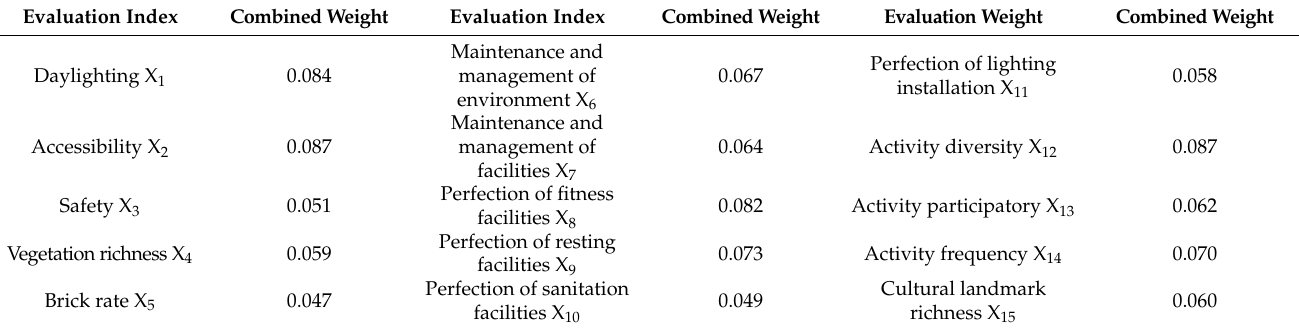
Table 5. Weight of evaluation index of public space satisfaction of new centralized